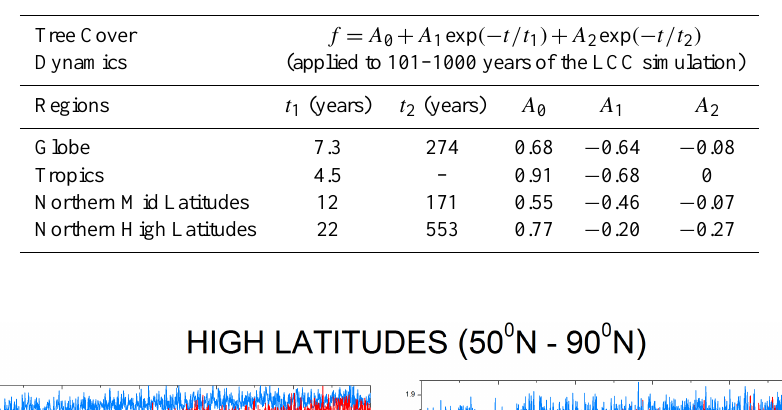
Table 1. Values of the constants in the exponential fit (Eq. 1) for the dynamics of fractional tree cover ( f ) plotted in Fig. 2 for different